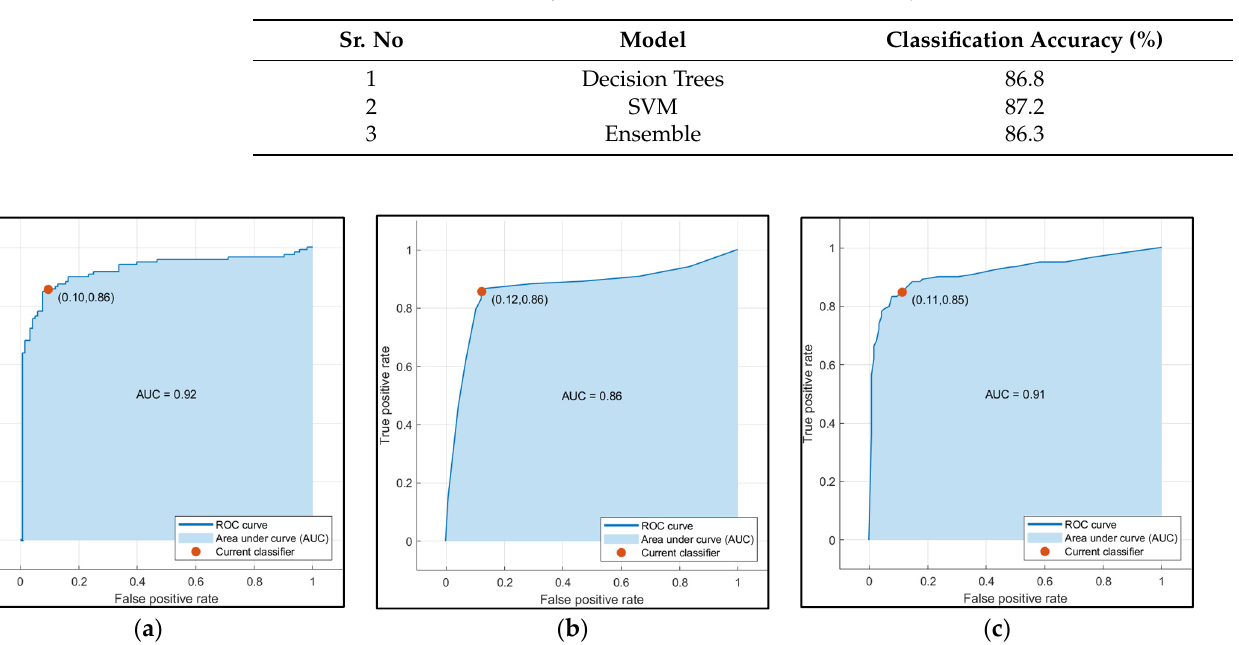
Figure 12. ROC curve for ( a ) SVM ( b ) Decision Trees and ( c ) Ensemble. From Figure 10b, the autocorrelation for AD patients was lower than compared to CN subjects. The uniformity in volumes of AD patients was higher than that of CN sub- jects, and the difference between neighbouring pixels was lower than that of CN subjects, as can be observed from Figure 10c. The randomness of intensity distribution was high for CN and was low for AD subjects. AD subjects had slightly more linear structures com- pared to CN. Figure 13 shows the comparative analysis of the volume data between AD and CN groups and it is seen that there is a noticeable distinction among the data samples. Figure 13. Comparison of volume data between AD and CN groups. In the next phase, classification models were trained only on the GLCM characteris- tics that had been identified. For textural features, Ensemble provided the highest accu- racy (85%) at d = 1 and direction ( d , d , 0), while Decision Trees was least accurate at d = 2 012345 AD CN V O L U M E 'Group' vs 'Volume' Average of Hippocampus Right Average of Hippocampus Left Average of Hippocampus Average of CA1 Right Average of CA1 Left Average of CA1 Average of CA2-CA3 Right Average of CA2-CA3 Left Average of CA2-CA3 Average of CA4-DG Right Average of CA4-DG Left Average of CA4-DG Average of SR-SL-SM Right Average of SR-SL-SM Left Average of SR-SL-SM Average of Subiculum Right Average of Subiculum Left Average of Subiculum